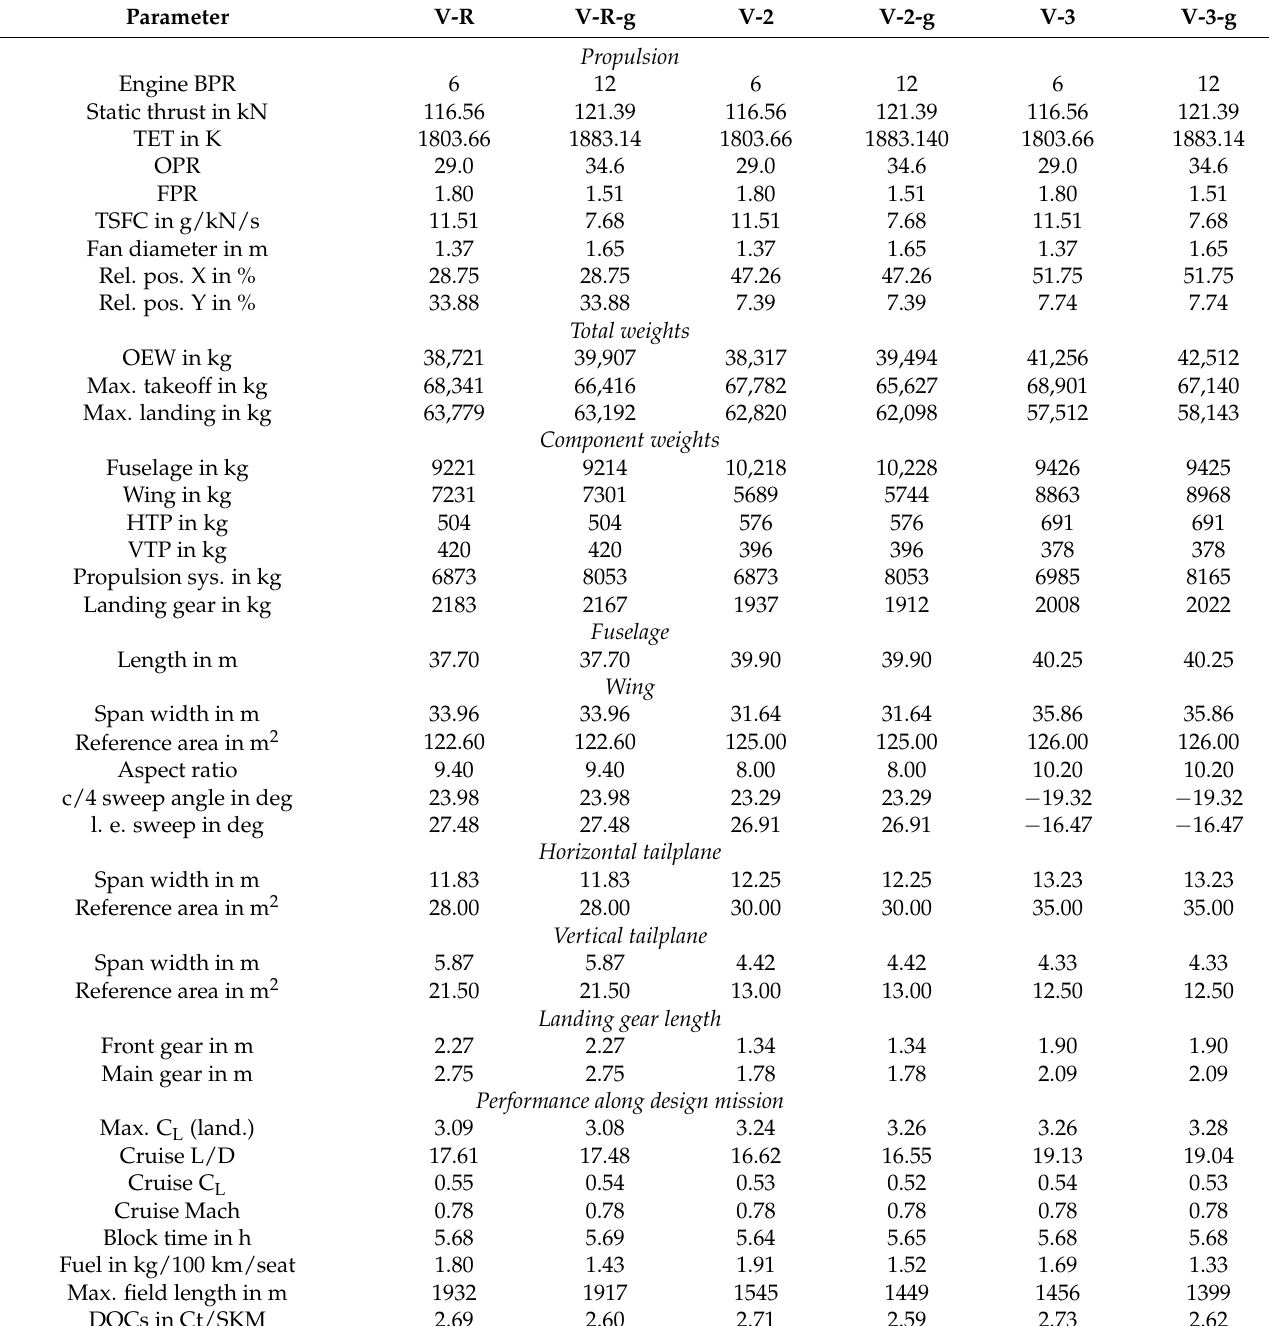
Table 4. Aircraft design and performance